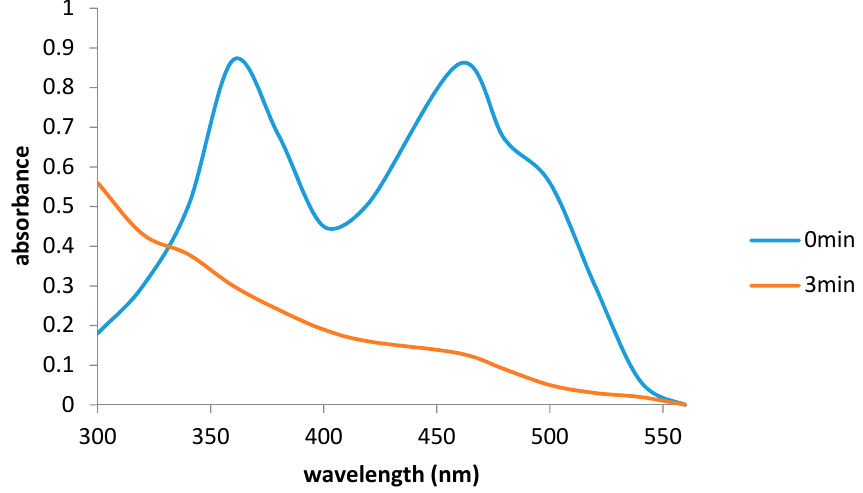
Figure 3. Frp1-dependent reduction of flavin monooxygenase (FMN) (40.0 μ M) by nicotinamide adenine dinucleotide (NADH) (100.0 μ M).